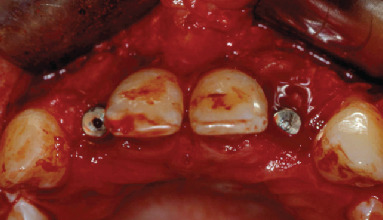
Implant placement.